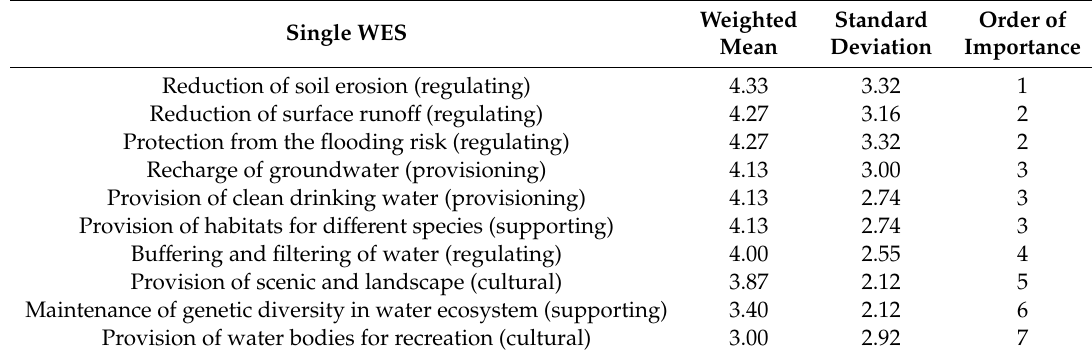
Table 4. The level of importance of single WES according to the Slovak stakeholders (Q1). Single WES